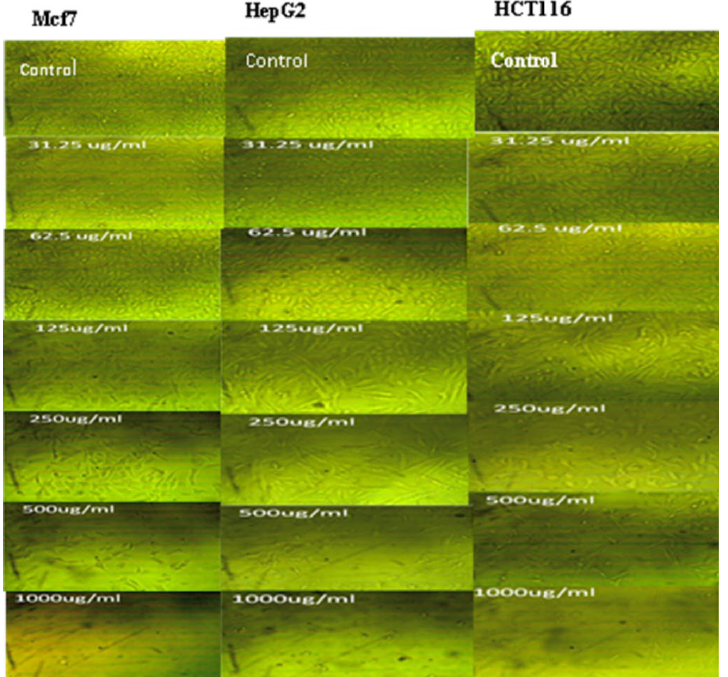
Fig. 8. Morphology of Mfc7, HepG2 and HCt116 cancer cell lines after exposure to different concentrations (0-1000 ϻg/mL) of Streptomyces mutabilis M3 MT483919 extract for 72